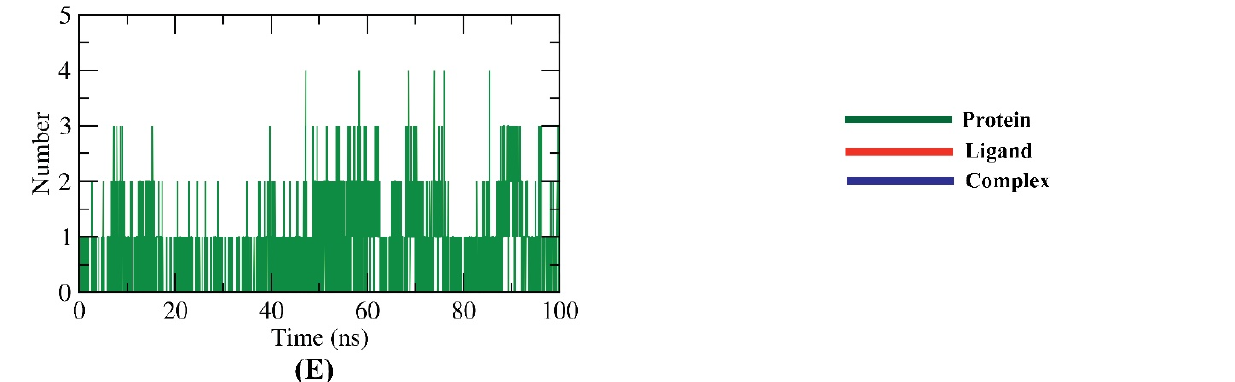
Figure 11. Molecular dynamics simulations results; ( A ) RMSD values of 6-demethoxy-4`-O-capillarsine, PLP and 6-demethoxy-4`-O-capillarsine -PLP complex during MD runs. ( B ) RMSF for PLP in the MD run. ( C ) Radius of gyration of PLP in the MD run. ( D ) SASA of PLP in the MD run. ( E ) H- bonding between 6-demethoxy-4`-O-capillarsine -PLP complex in the MD run.